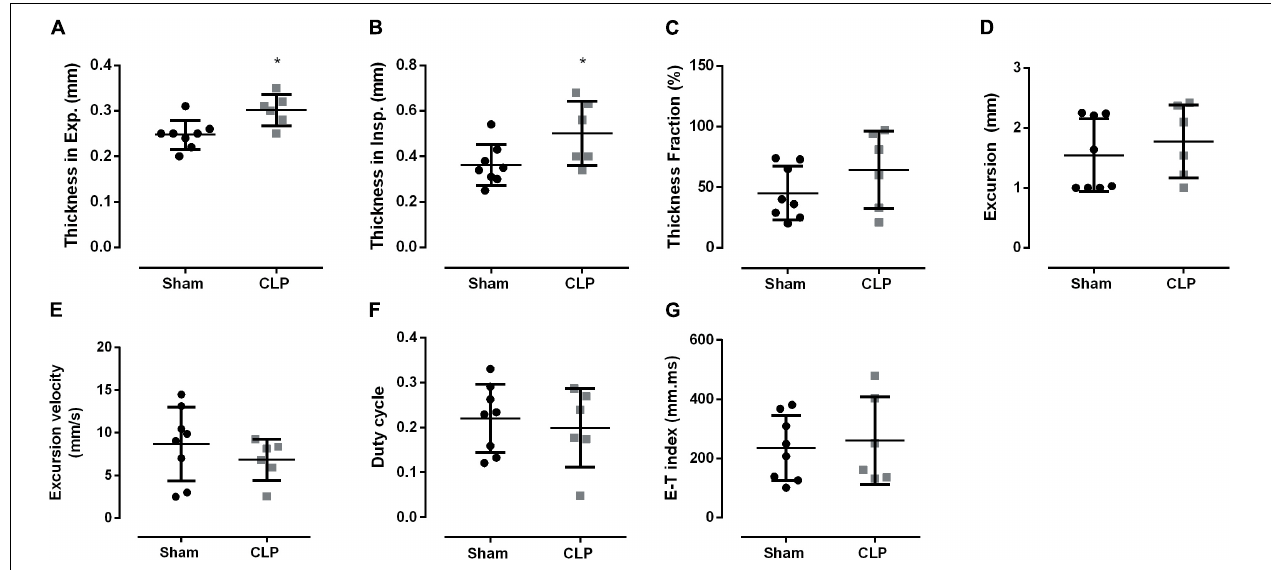
FIGURE 4 | Diaphragm function is maintained during sepsis. Diaphragm thickness during expiration (A) and inspiration (B) ; thickness fraction, an indication of contractability work, is the measure of the thickness on inspiration minus the thickness on expiration divided by the thickness on expiration (C) ; excursion (movement amplitude, D ); excursion velocity (E) , duty cycle (inspiratory duration/peak to peak, F ), E–T index (G) . Black dots represent sham animals caused by surgical stress, and gray squares represent CLP – cecal ligation puncture technique. Values are expressed as mean ± SD and * p < 0.05 compared with the sham group.